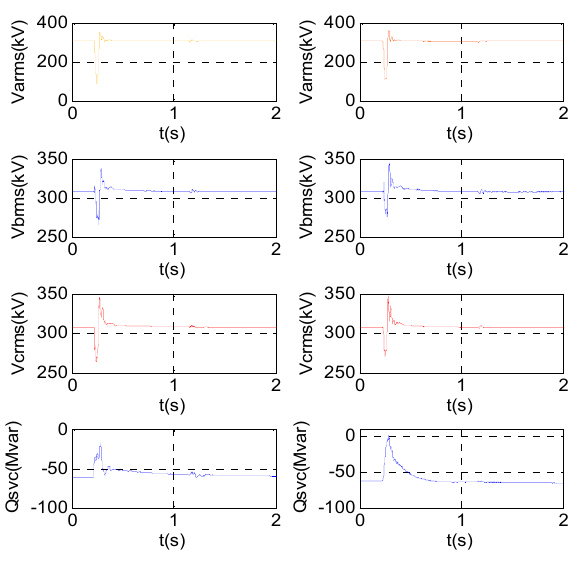
Figure 18. Dynamic response of the system and SVC under an artificial short-circuit grounding test.